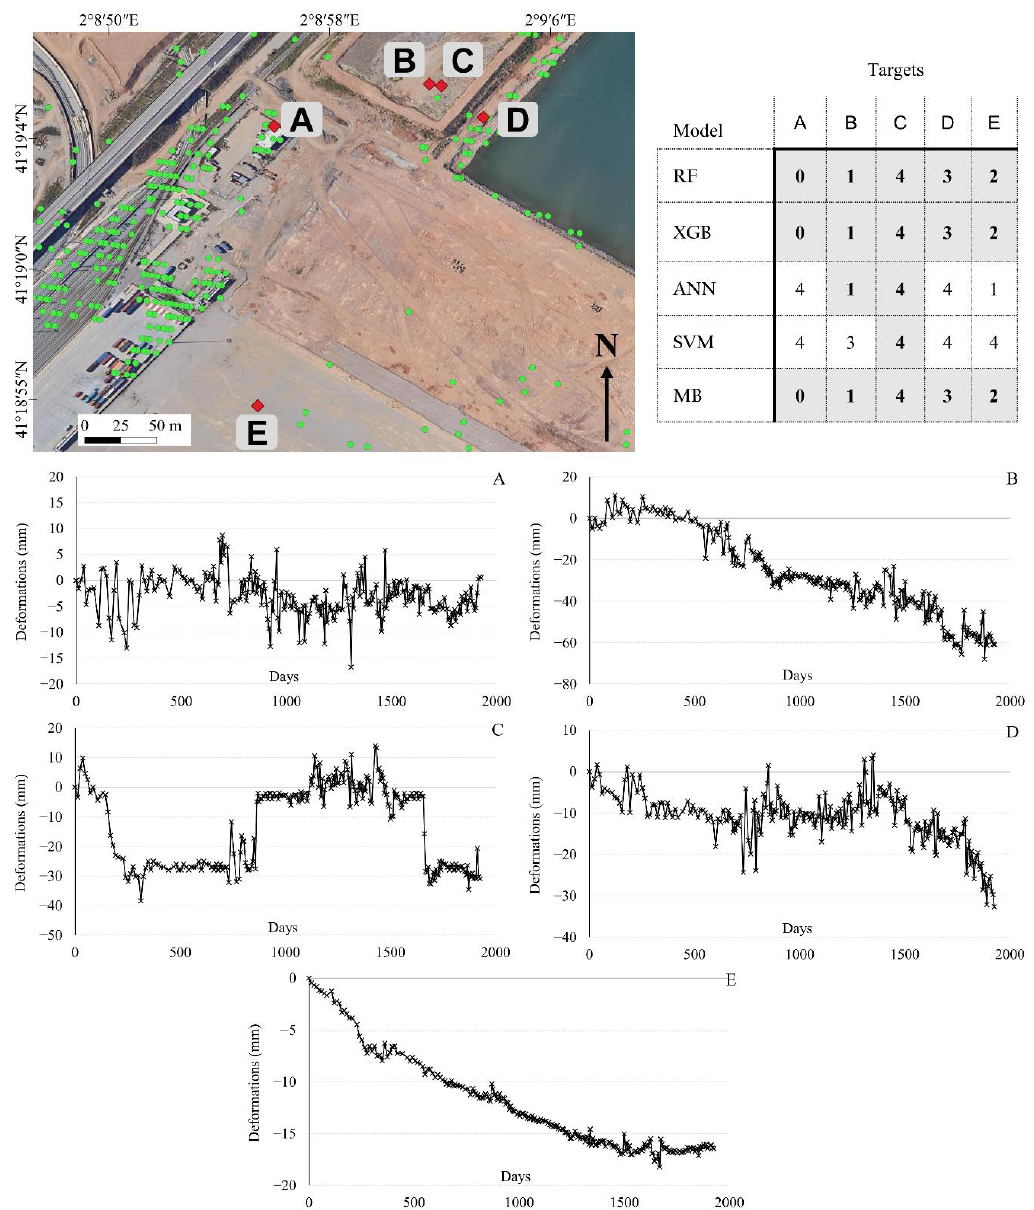
Figure 6. Five selected samples from Barcelona Harbour (red points), along with the corresponding TSs that were selected from detected persistent scatterers (green points). The table summarises the predicted classes, where values refer to 0: Stable, 1: Linear, 2: Quadratic, 3: Bilinear, and 4: PUE. The corrected classified TSs are highlighted in the table.